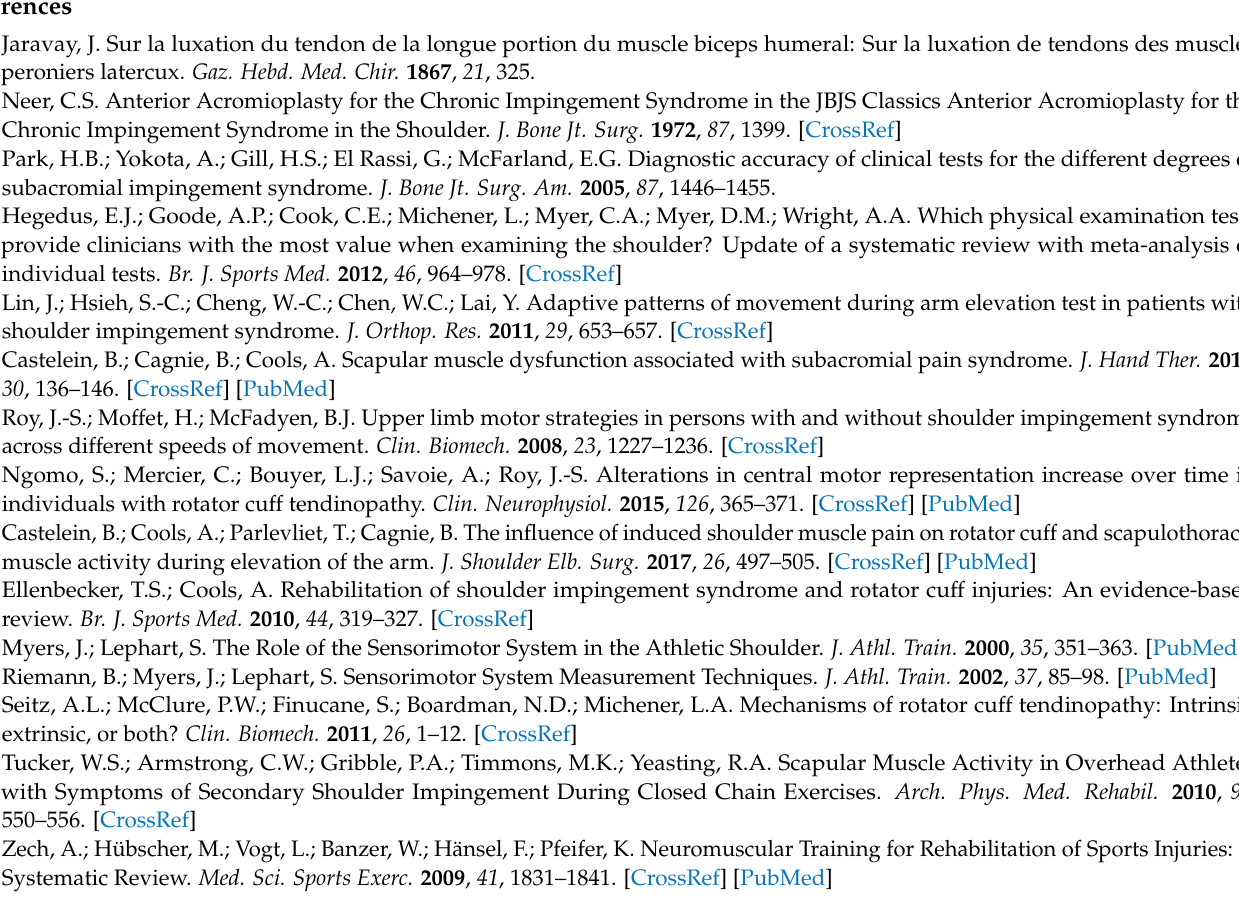
Figure A2. GHJ: Glenohumeral joint. ST: Scapulothoracic joint. ACJ: Acromioclavicular joint. SCJ: Sternoclavicular joint. RC: Rotator